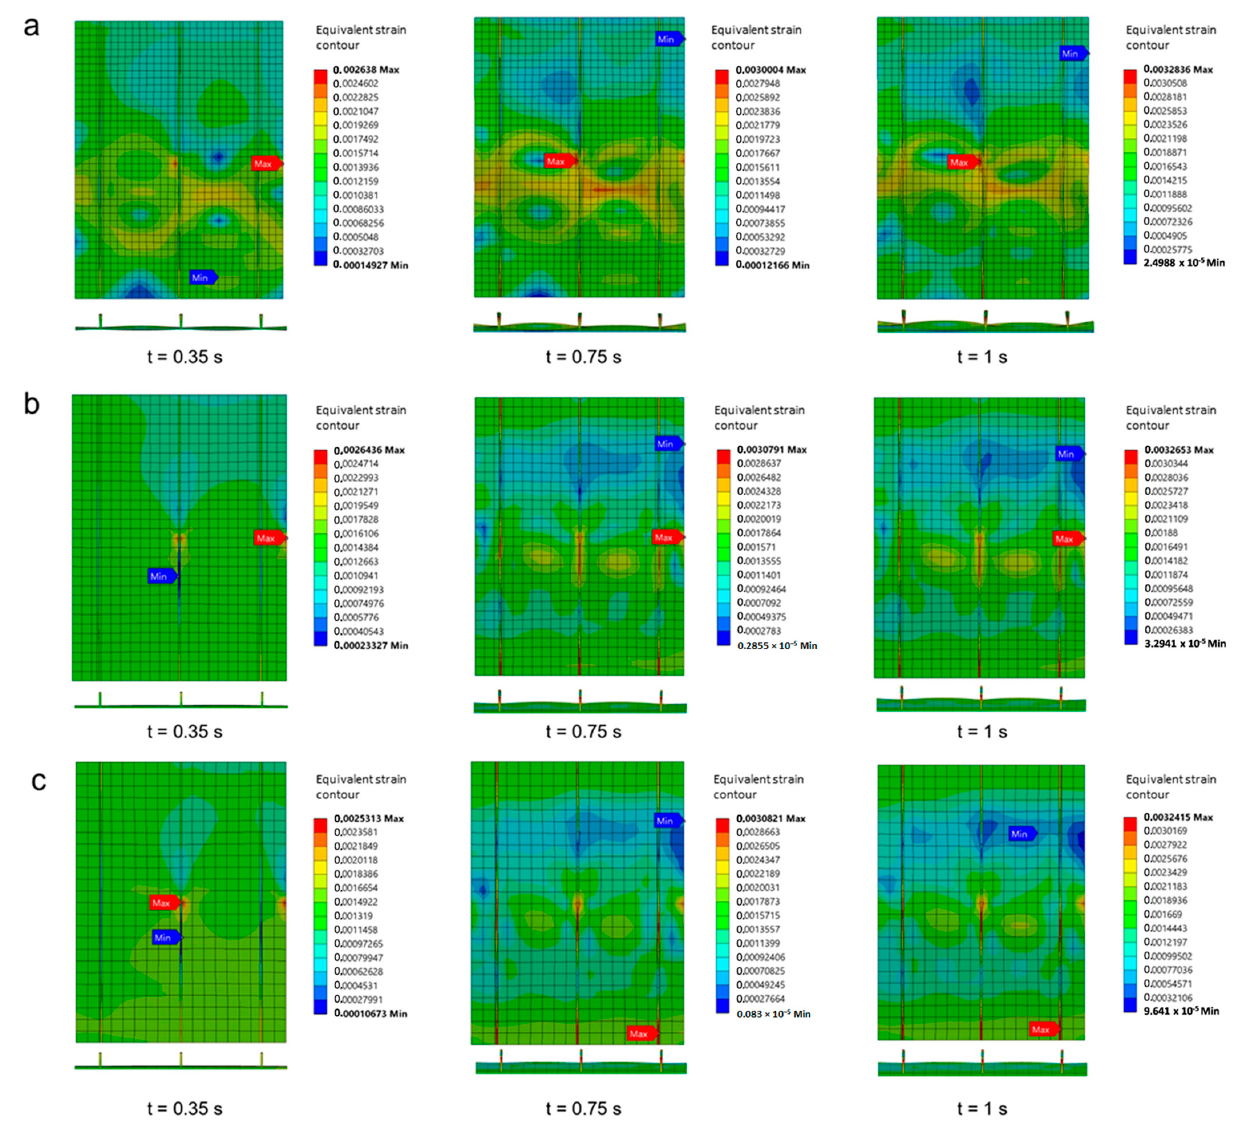
Figure 20. Equivalent strain contour in Specimen A: ( a ) 3 mm plate thickness; ( b ) 4 mm plate thickness; ( c ) 5 mm plate thickness.